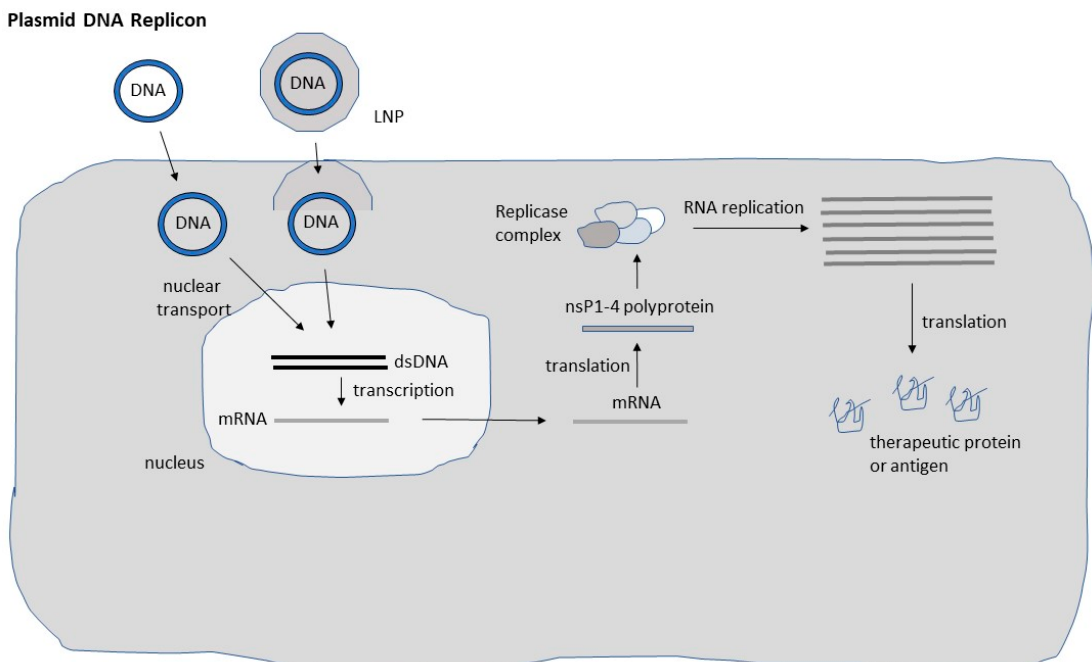
Figure 2. Schematic presentation of DNA replicon systems. Both naked and lipid nanoparticle (LNP) encapsulate DNA replicons have been used. DNA replicon delivered to the nucleus is in vivo transcribed and mRNA translocated to the cytoplasm for translation of the non-structural (nsP1-4) polyprotein, which is processed to individual nsP1-4 proteins forming the replicase complex. The replicase complex is responsible for massive self-replication of RNA, leading to the translation of high levels of recombinant protein or antigen.